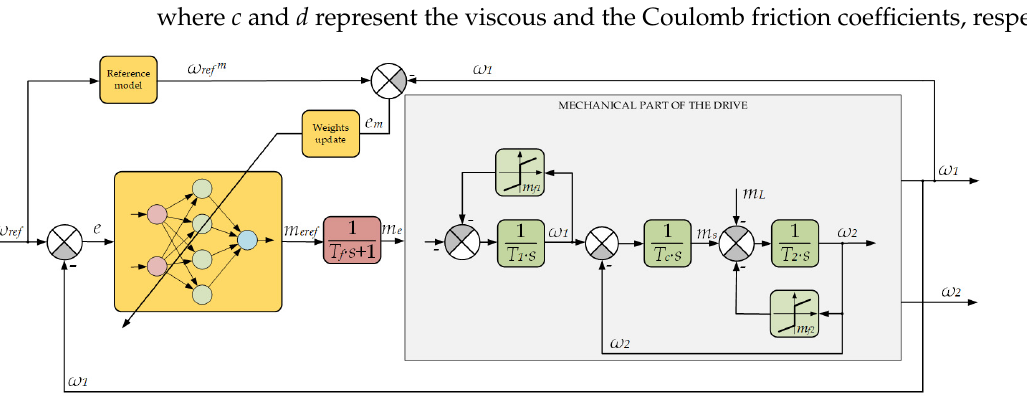
Figure 1. Schematic diagram of the adaptive control with the RWNN model.